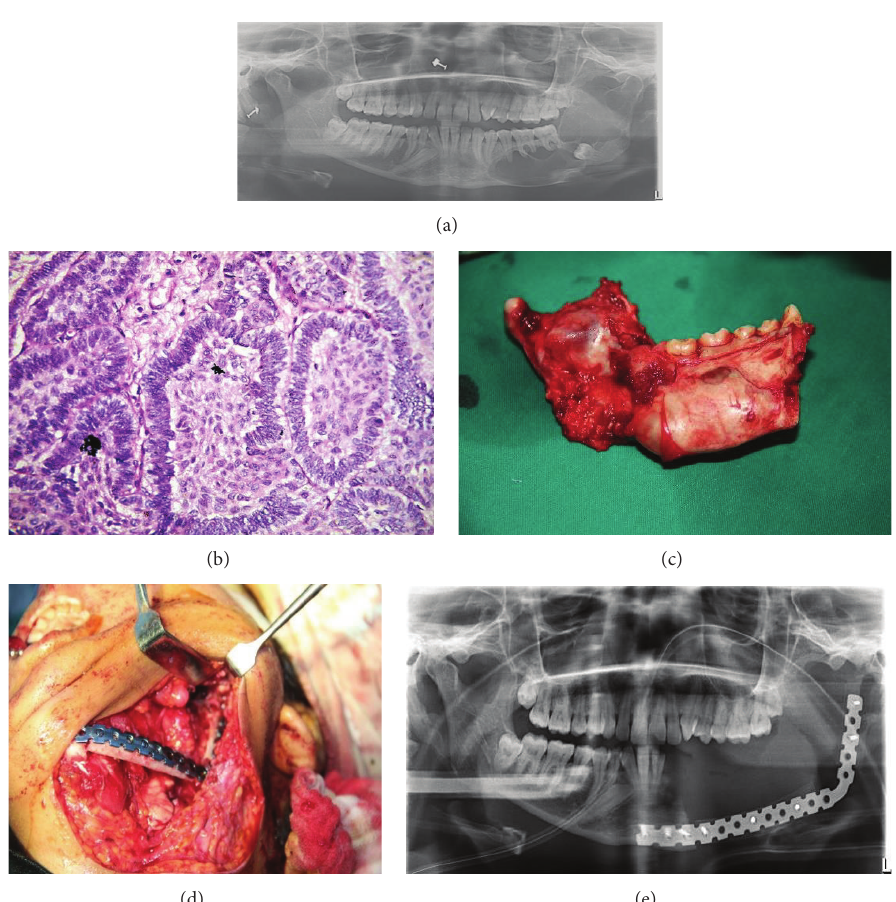
Figure 5: (a) Preoperative OPG. (b) Histopathological examination. (c) Specimen. (d) Rib graft with reconstruction. (e) Postoperative view